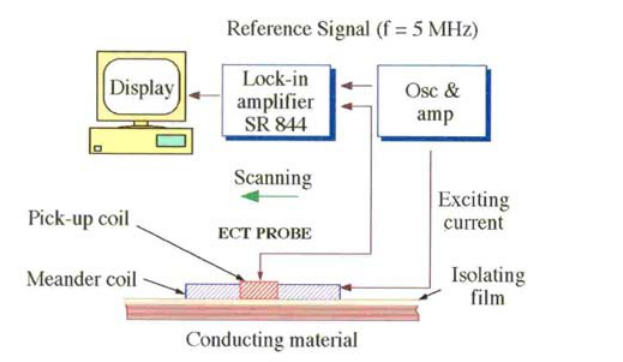
Figure 26. The experimental set-up for PCB inspection.